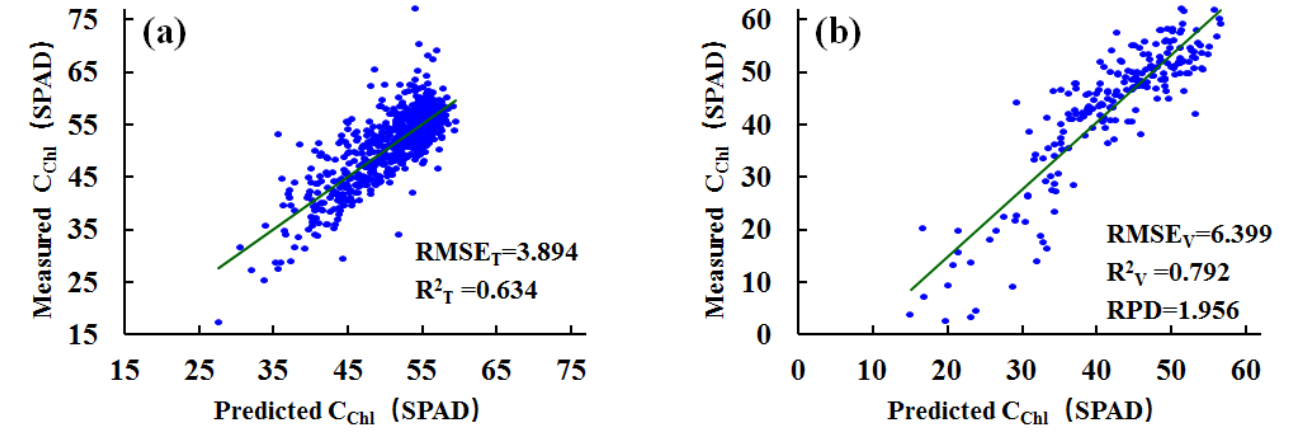
Figure 9. The estimated results of SPAD value for ( a ) training set and ( b ) validation set at whole growth stage.